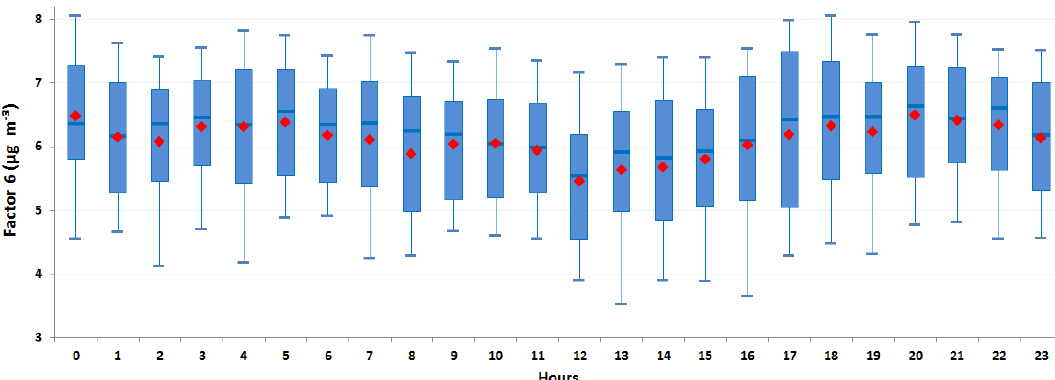
Figure 13. Diel variation in the VOC factor 6 contributions represented by hourly box plots. Blue solid line represents the median contribu- tion, the red marker represents the mean contribution and the box shows the interquartile range. The bottom and the top of the box depict the first and the third quartiles (i.e., Q1 and Q3). The ends of the whiskers correspond to the first and the ninth deciles (i.e., D1 and D9). Time is given as local